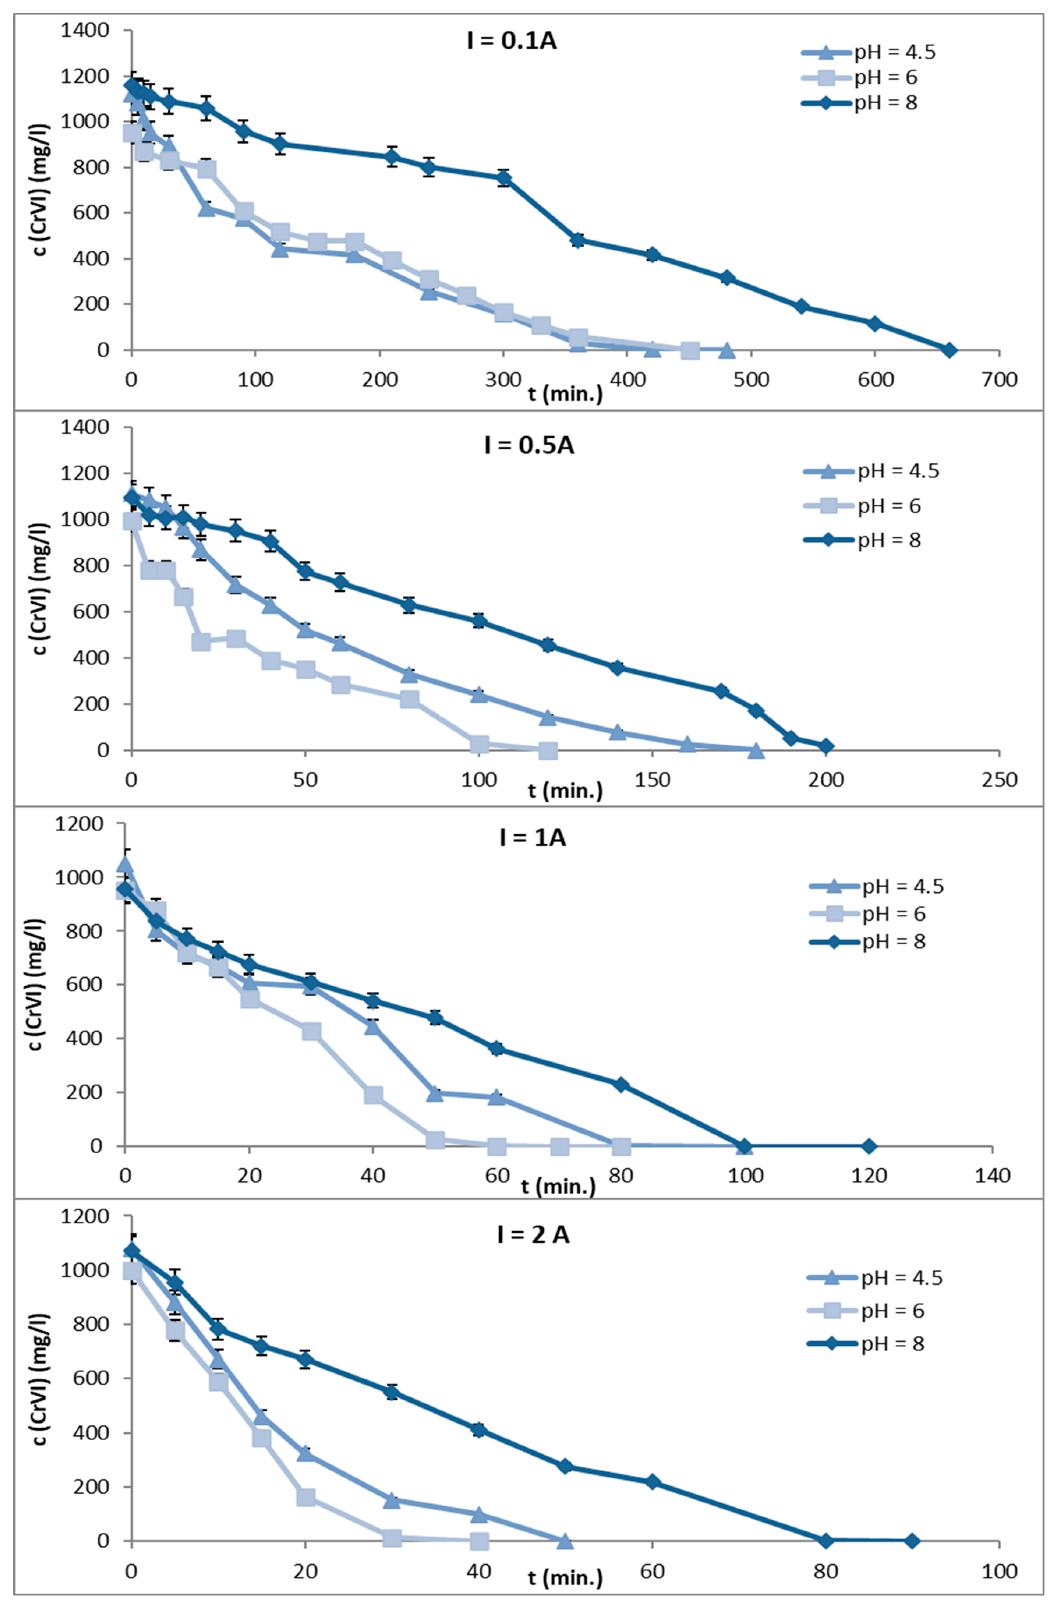
Figure 2. Decrease in Cr concentration in model solutions at pH 4.5, 6, and 8 for current intensities of 0.1, 0.5, 1, and 2 A.